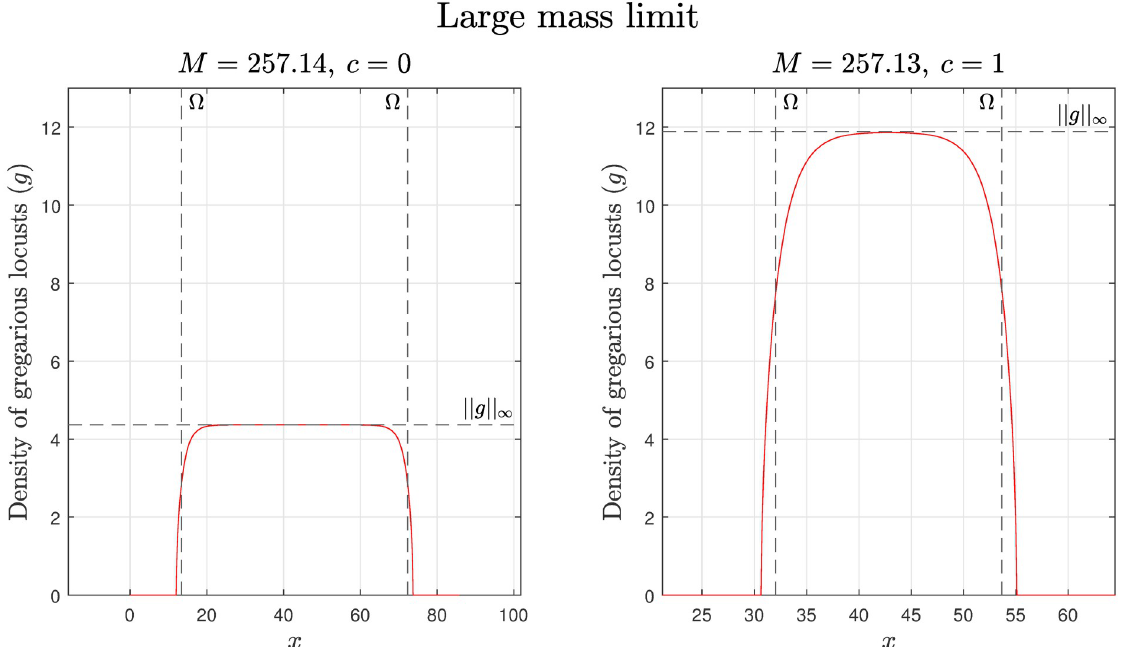
Fig 1. Large mass limit with estimates for the max value and support. The estimates of the max value and support are labelled || g || 1 and O respectively, with simulation results given by the red lines. For both the simulation and calculations D = 0.01, γ = 60, R 1, and c = 0 and 1. As the mass M is increased the gregarious locust shape g becomes increasingly rectangular as the maximum locust density does not depend on the total mass. In addition as the amount of food is increased from c = 0 on the left to c = 1 on the right, the maximum density for the gregarious locusts